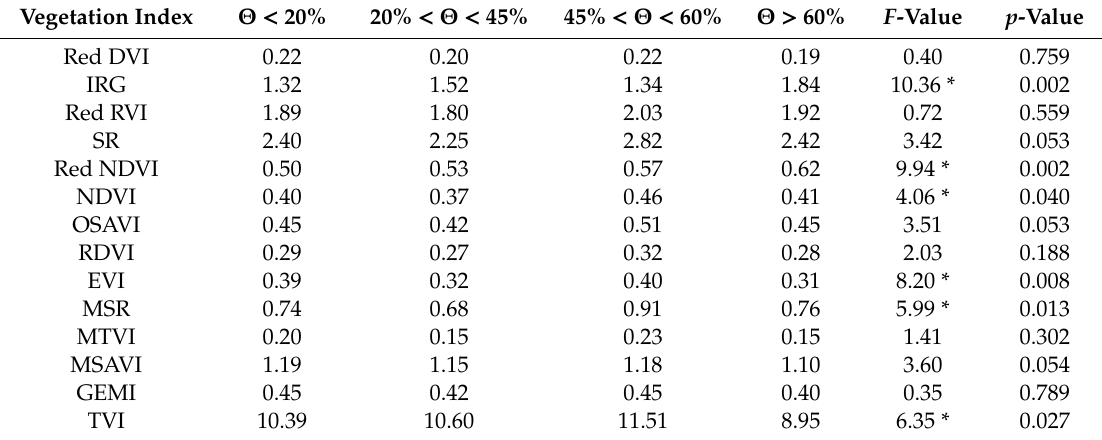
Table 3. Analysis of variance for Carpobrotus vegetation indices for di ff erent water content levels ( Θ ). Vegetation Index Θ < 20% 20% < Θ < 45%